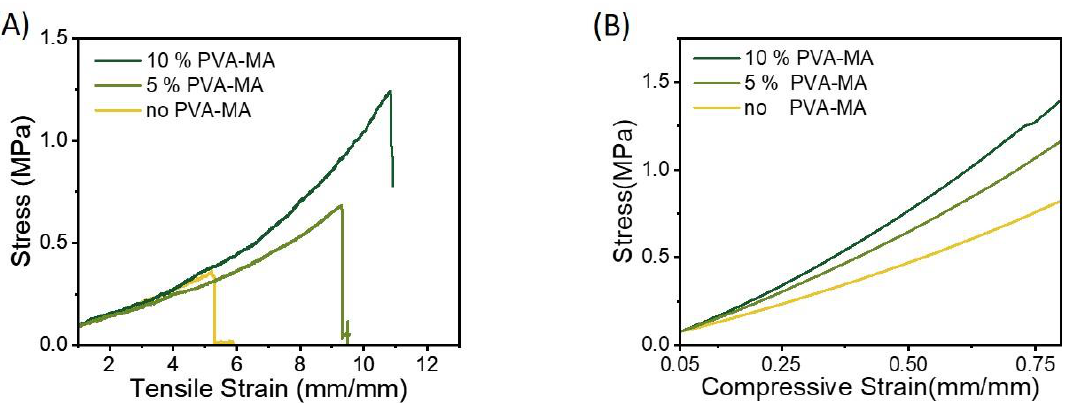
Figure 3. Tensile ( A ) and compressive ( B ) stress – strain curves of PVAx/(PVA-MA)-g-PNIPAM (x = 0, 5, 10) hydrogels.